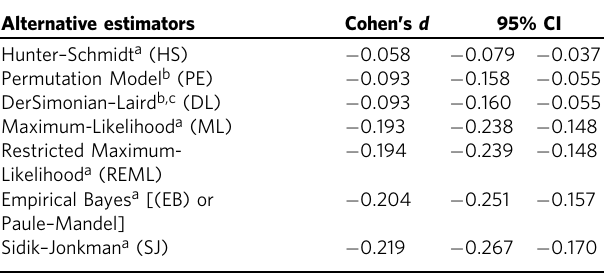
Table 1 Overall effect size per estimator.